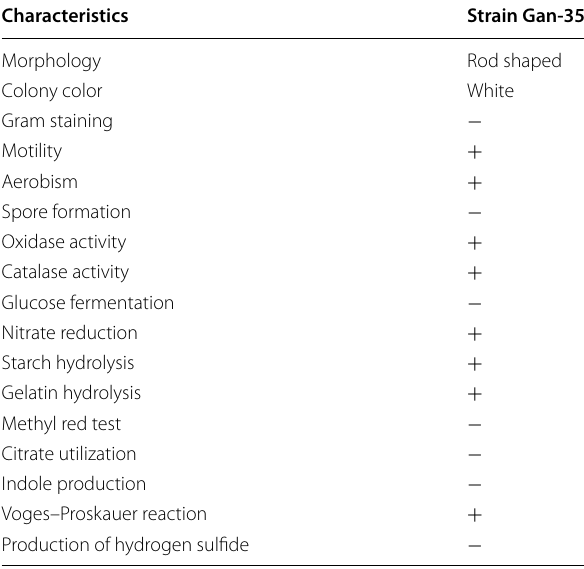
Table 2 Morphological, physiological and biochemical characteristics of strain Gan-35